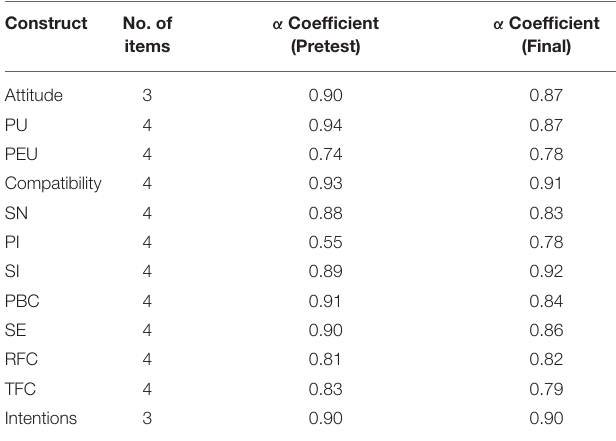
TABLE 2 | Pretest and final study scale reliability using Cronbach’s α .